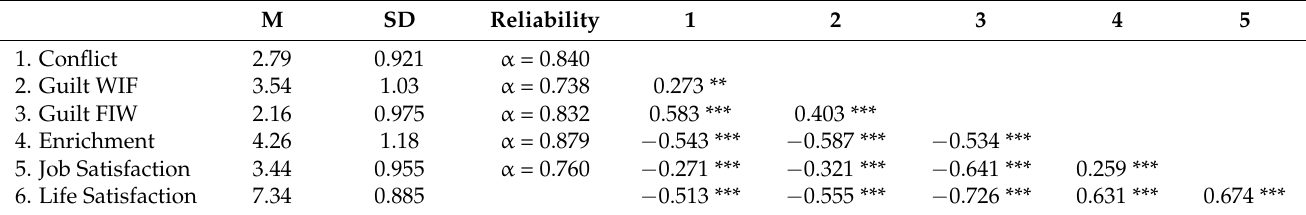
Table 2. Means, standard deviation, reliability and correlations.